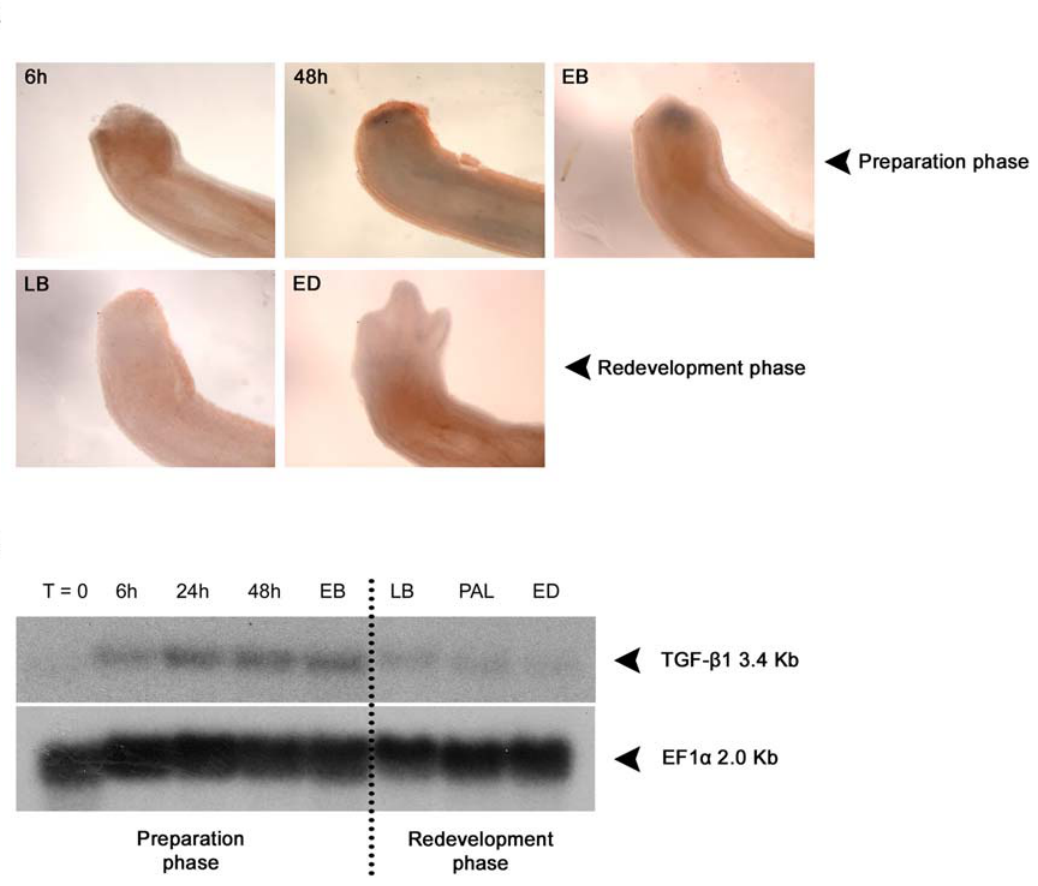
Figure 2. Expression of TGF- b 1 during axolotl limb regeneration. A) Expression of TGF- b 1 determined by whole-mount in situ hybridization in axolotl forelimbs. Limbs were amputated distally through radius/ulna. Samples were fixed at various times after amputation: 6 hours (6 h), 48 hours (48 h), early bud (EB), late bud (LB) and early differentiation (ED) stage. TGF- b 1 expression is found as a dark purple precipitate. The 3 stages on the upper row are part of the preparation phase of limb regeneration. The 2 stages on the lower row are part of the redevelopment phase of limb regeneration. B) Northern blot showing expression of TGF- b 1 at various stages of forelimb regeneration. TGF- b 1 was detected as a 3.4 Kb transcript. RNA was extracted from regenerating blastemas at various times after amputation: 6 hours (6 h), 24 hours (24 h), 48 hours (48 h), early bud (EB), late bud (LB), palette (PAL) and early differentiation (ED) stage. T=0: RNA was extracted from an unamputated mature limb. The dotted line marks a distinction between regeneration stages included in the preparation phase and those included in the redevelopment phase of